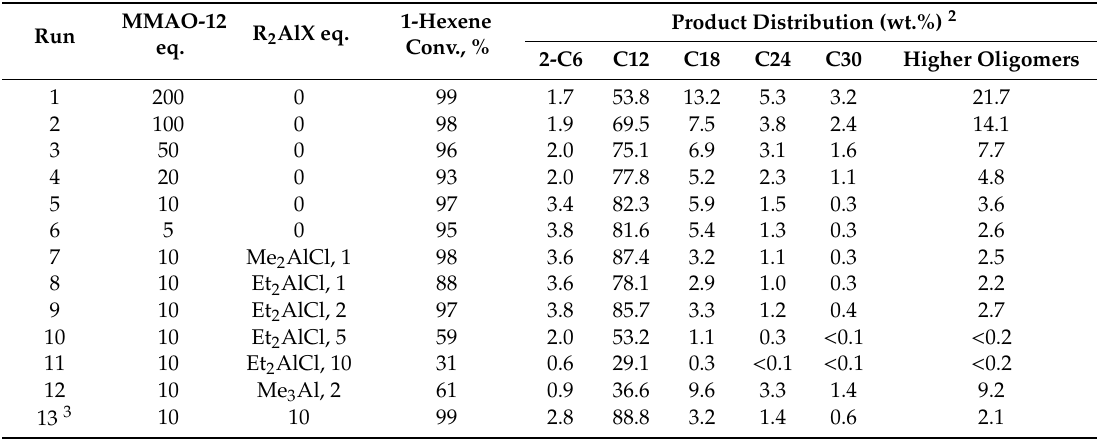
Table 2. Zirconocene-catalyzed oligomerization of 1-hexene (in bulk, 60 ◦ C, 4 h).